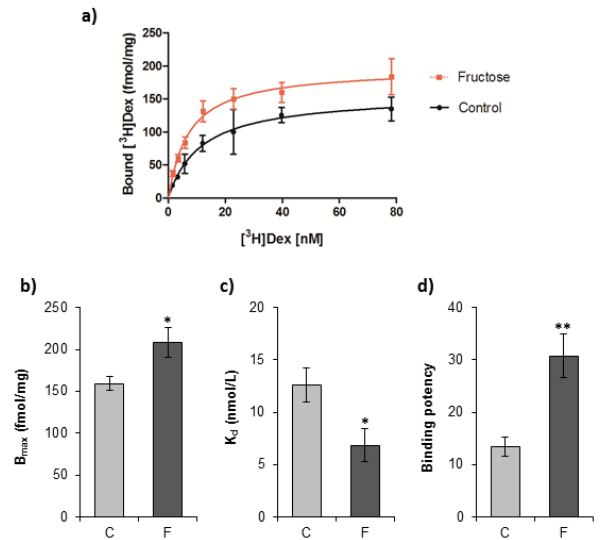
Figure 2. In vitro dexamethasone binding to glucocorticoid receptor (GR) from the liver of female rats subjected to a fructose-rich diet. Groups: control (C), fructose-fed (F). To measure dexamethasone binding to GR, aliquots of cytosols were incubated (18 h, 0 C) with increasing concentrations of